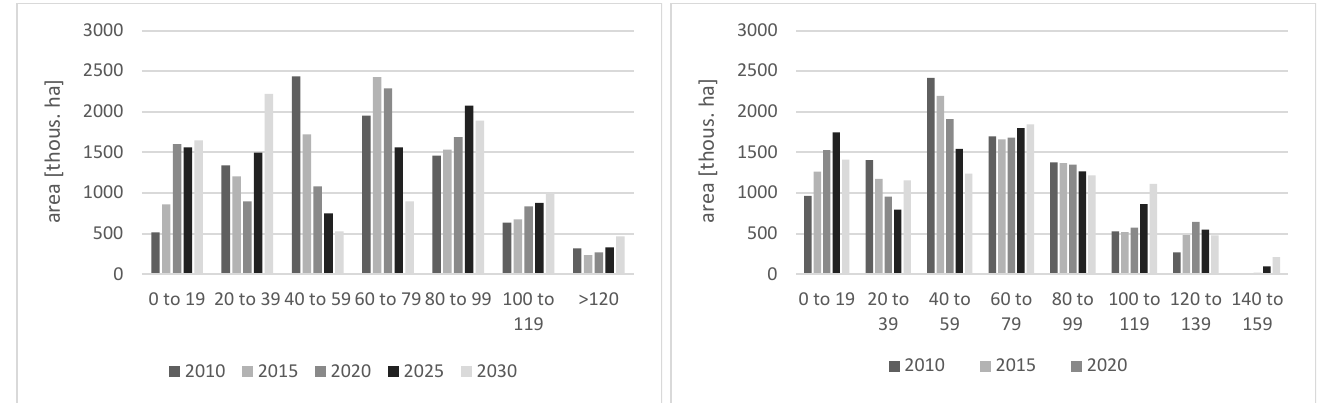
Figure 9. Age–class distribution over the area in the modelling years. Comparison between EFDM (on the left ) and CBM (on the right ) output